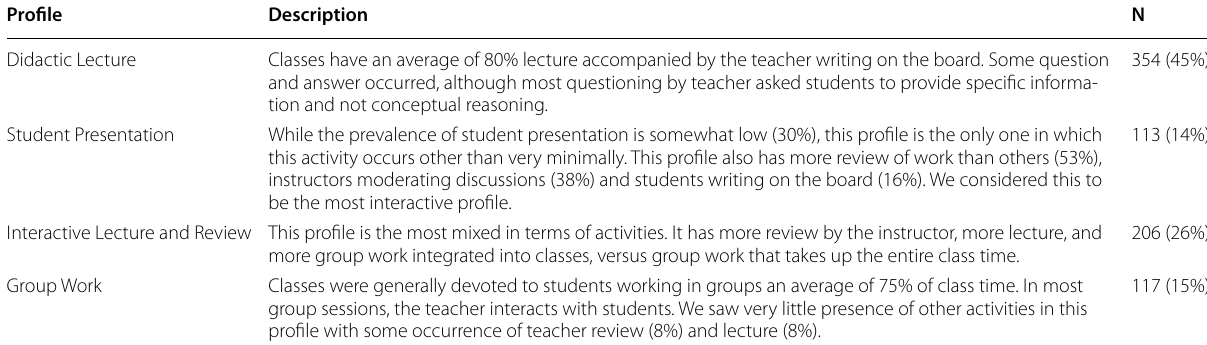
Table 5 Characterization of four latent profiles Profile